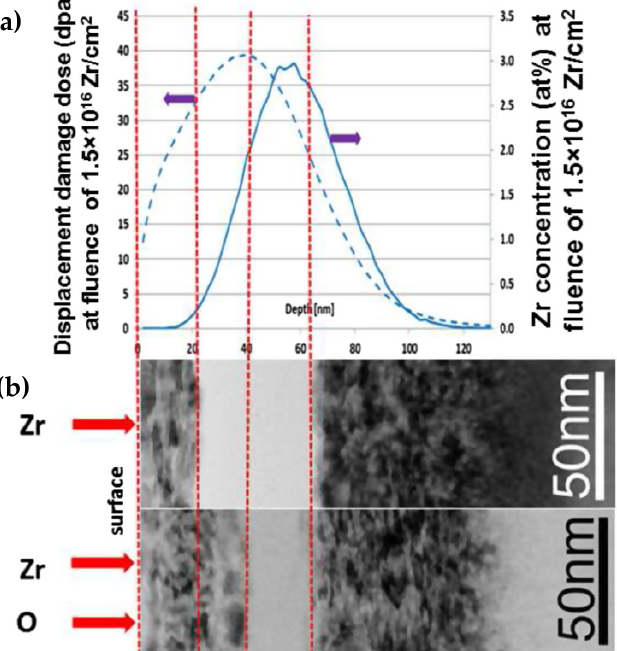
Figure 9. Cross-sectional TEM images of α -Al 2 O 3 ( a ) irradiated with Zr + ions to 1.5 × 10 16 ions/cm 2 and subsequently with ( b ) O + ions to 2.3 × 10 16 ions/cm 2 , demonstrating the extent of recrystallization of the buried amorphous layer. Overlaid SRIM damage (blue dotted line) and ion range (solid blue line) profiles show a clear relationship between the observed phase structures and the irradiation damage and Zr + ion implantation peaks (red dotted lines). Reproduced with permission from ref.